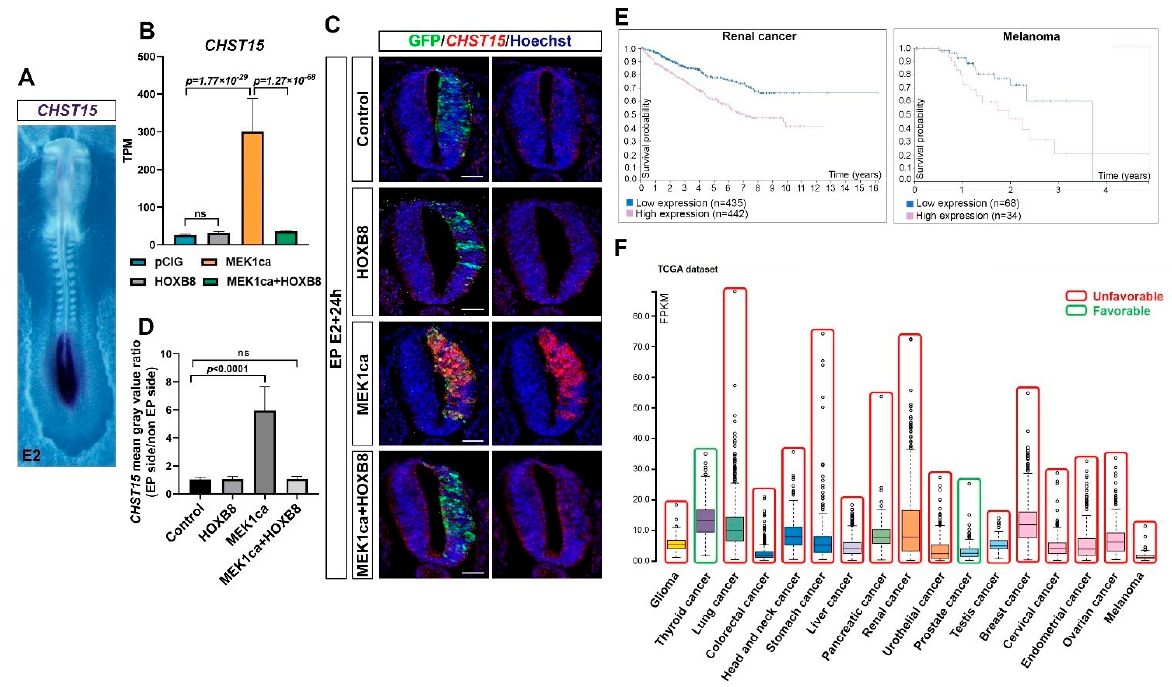
Figure 6. CHST15 upregulated by MEK1ca and reversed by HOXB8 is unfavorable for many cancers. ( A ) Dorsal view of a 2-day-old chicken embryo after whole mount in situ hybridization with a CHST15 probe highlighting its expression only in the most caudal part of the embryo. ( B ) Mean expression of CHST15 in TPM (transcripts per kilobase million) obtained for the two replicates of the control- (pCIG1, pCIG2), HOXB8- (HOXB8-1 and HOXB8-2), MEK1ca- (MEK1ca-1 and MEK1ca-2) and MEK1ca + HOXB8 (MEK1ca + HOXB8-1 and MEK1ca + HOXB8-2)-expressing samples, with the corresponding p-value according to the DGE (FDR5) of each pair. ( C ) Fluorescence in situ hybridization with a CHST15 probe and immuno-fluorescence staining with the anti-GFP antibody on transverse trunk sections of chicken embryos one day post-electroporation in the pCIG, HOXB8, MEK1ca and MEK1ca + HOXB8 conditions. Blue is Hoechst staining. Scale bar: 50 µm. ( D ) CHST15 staining mean gray value ratio (electroporated/contralateral side) one day after electroporation in the four conditions (n = 3 animals/18 sections) (two-tailed Mann–Whitney test, error bars represent the SD). ( E ) Survival analysis data from the Human Protein Atlas (courtesy of the Human Protein Atlas, www.proteinatlas.org, 15 May 2021) highlighting that CHST15 displays high expression correlated with poor outcomes in renal and melanoma human cancers. ( F ) RNA expression overview (RNA-Seq data in 17 cancer types as the median FPKM (fragment per kilobase of exon per million reads) generated by The Cancer Genome Atlas (TCGA) (Courtesy of Human Protein Atlas, www.proteinatlas.org, 15 May 2021)), to which we added a color code (red—unfavorable, green—favorable) to highlight that most cancers (15/17) have high expression correlated with poor outcomes in the survival analysis data (Human Protein Atlas).